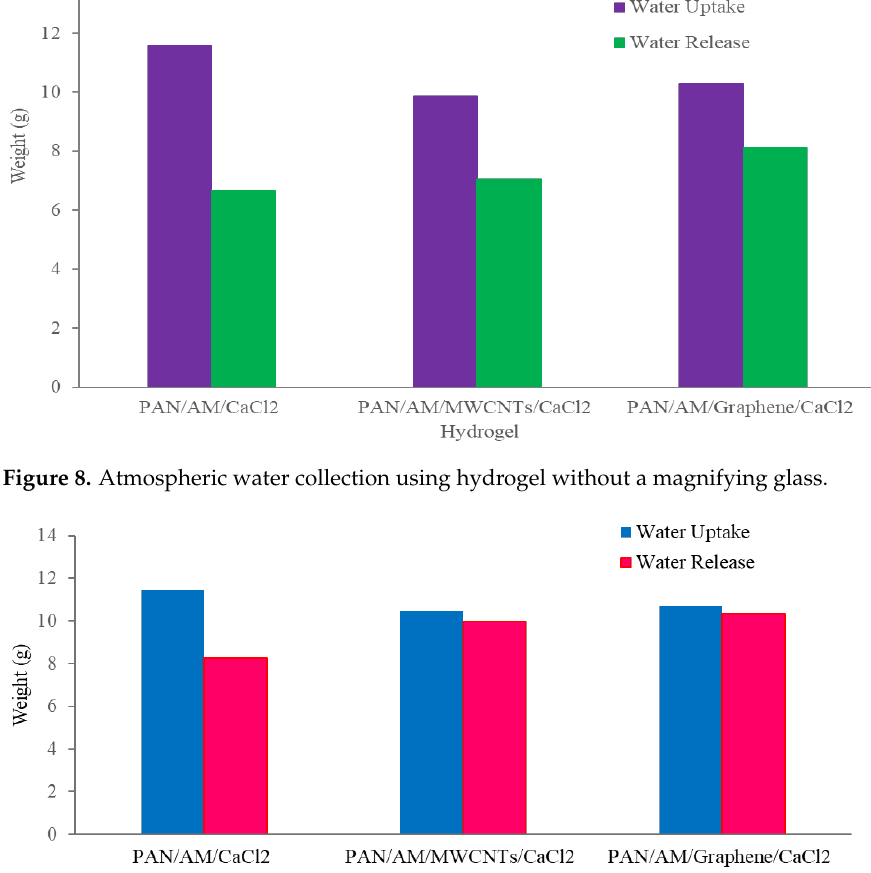
Figure 10. Digital photos of water collection: ( a ) device prototype based on PAN/AM/gra- phene/CaCl 2 hydrogel; and ( b ) condensed water on the wall of the box during the collection process. The stability and reusability of the fabricated hybrid hydrogel were studied using multi-cycle water vapor harvesting tests. One cycle of water collection included 12 h of the water uptake and 2.5 h of the water release process using the previously mentioned method, followed by air-drying, and drying in an oven for 30 min at 60 °C. The water vapor collection performance of the hydrogel was recorded after 5, 10, and 15 cycles. Figure 11 shows the water collection of the PAN/AM/graphene/CaCl 2 hydrogel for different water collection cycles (with magnifying glass). As can be seen, there was no obvious impairment in the water collection performance, even after 15 cycles of repetitive water collection. Like PAN/AM/graphene/CaCl 2 hydrogel, the water vapor collection